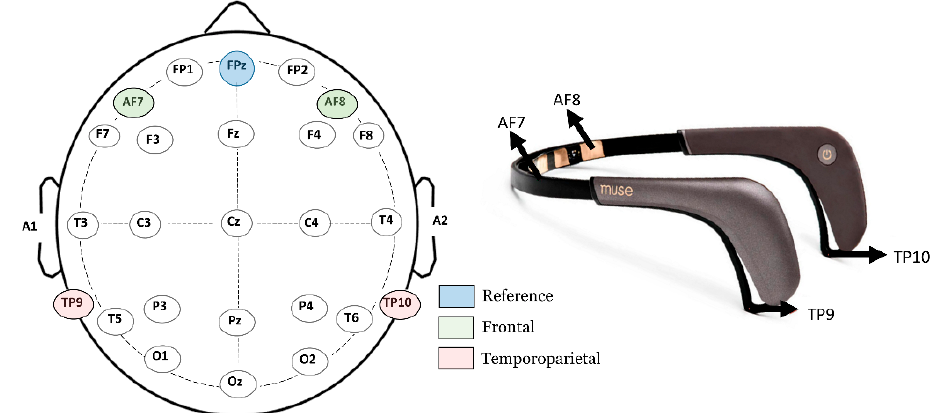
Figure 1. The four channels AF7, AF8, TP9, and TP10, highlighted in the 10–20 electrode placement scheme, and the EEG headband utilized to acquire EEG data.